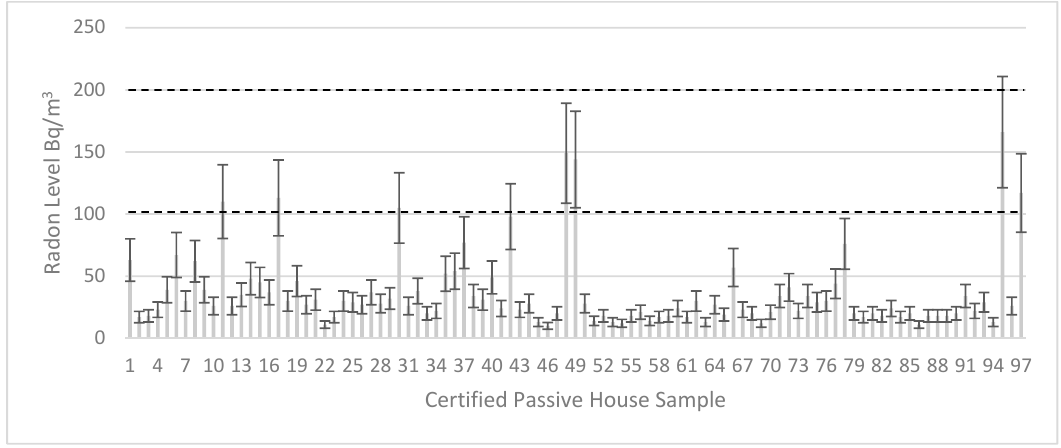
Figure 2. Passive House Sample (97 homes) with National Reference/Action Level 200 Bq/m 3 and WHO recommendation/Target Level 100 Bq/m 3 shown with the dashed lines.